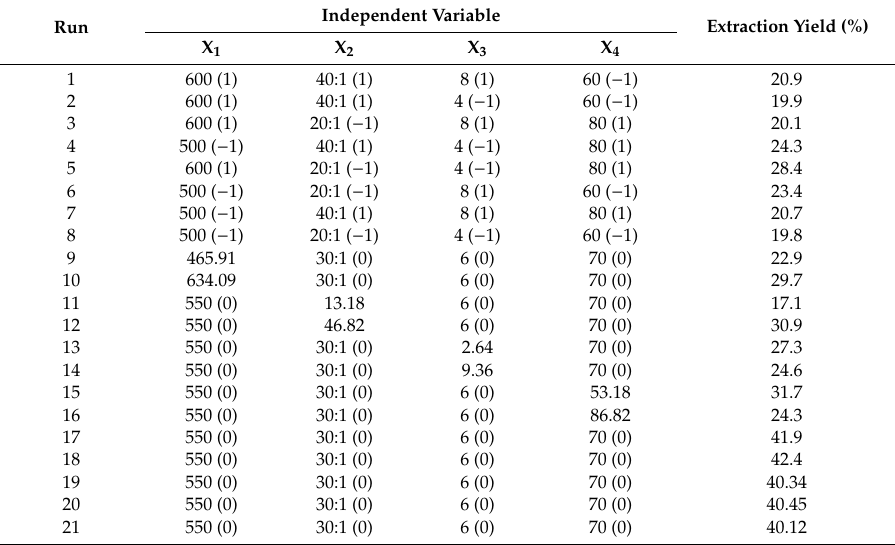
Table 1. Central composite design and observed